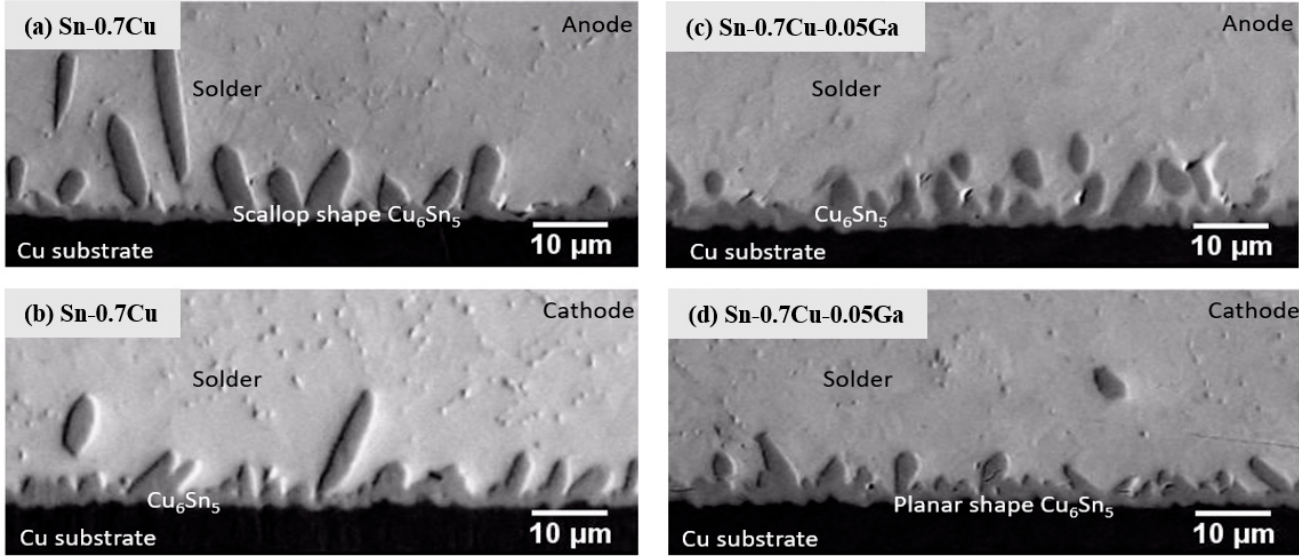
Figure 5. Intermetallic compound (IMC) formation of dipped solder after 3 days of electromigration: ( a ) Sn–0.7Cu at anode; ( b ) Sn–0.7Cu at cathode; ( c ) Sn–0.7Cu–0.05Ga at anode; ( d ) Sn–0.7Cu–0.05Ga at cathode.